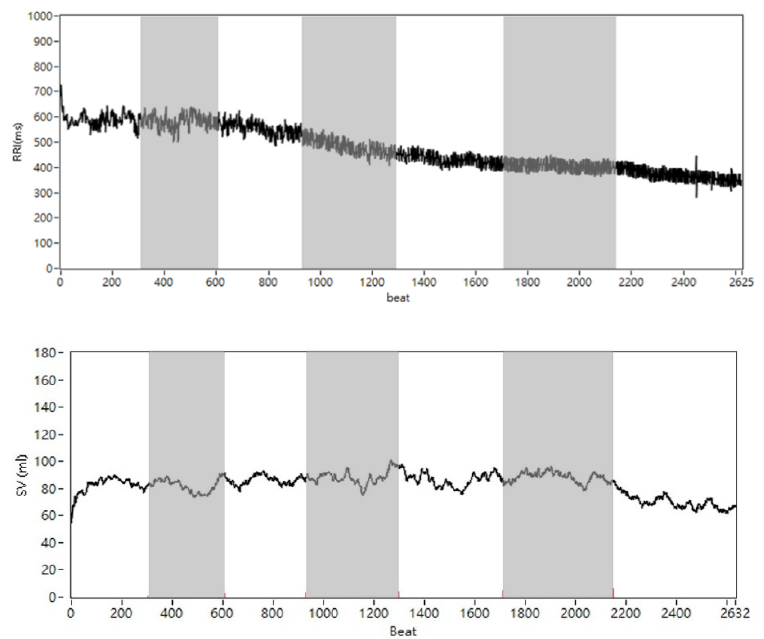
Figure 3. The time-domain demonstration of RR interval ( upper ) and SV series ( lower ) for patient #9. The white and gray blocks represent each sequence stage. The white and gray blocks represent each sequence stage.